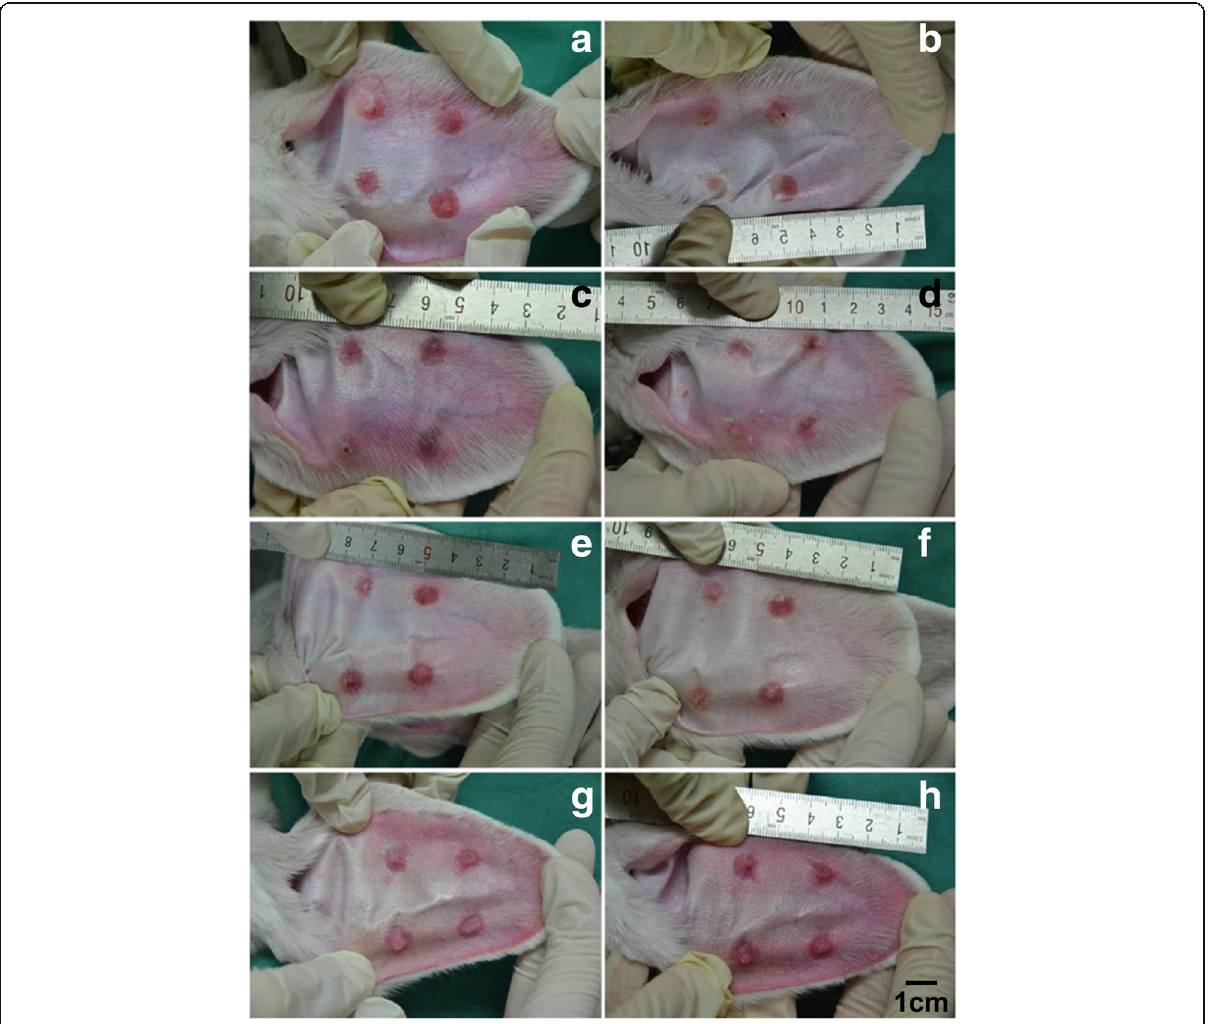
Fig. 6 Photographic imaging of rabbit hypertrophic scars before and after applied different treatments for 7 days. The 5EL group: the enthosomal gels encapsulated with 5-FU combined with CO 2 fractional laser, before ( a ) and after ( b ) treatment for 7 days; CO 2 group: CO 2 fractional laser, before ( c ) and after ( d )treatment for 7 days; 5E group B: the enthosomal gels encapsulated with 5-FU, before ( e ) and after ( f ) treatment for 7 days; and blank group: blank, before ( g ) and after ( h ) treatment for 7